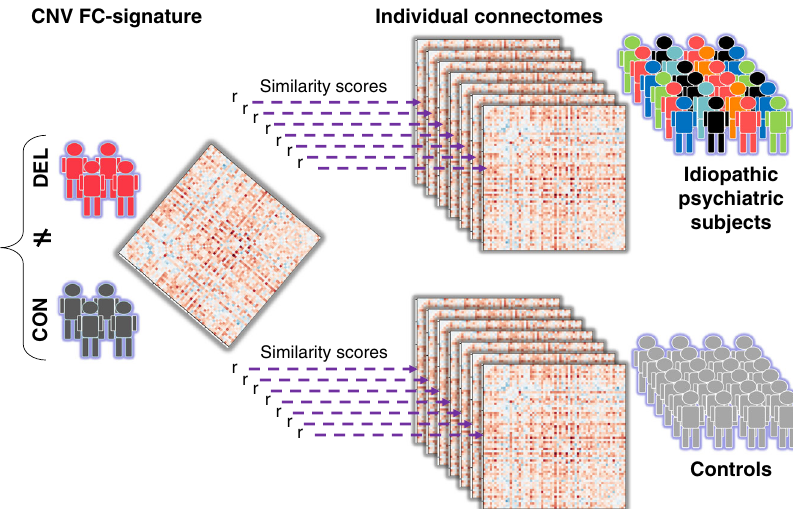
Fig. 3 Testing similarities across CNVs and idiopathic conditions. Similarities of FC-signatures across this study were characterized by correlating (Pearson ’ s r ) a group-level FC-signature with individual connectomes from either cases and controls. The r values obtained for all cases and all controls were compared using a Mann – Whitney test. Here, the group level connectome is represented by a matrix of 2080 beta values, on the left side. It is obtained by contrasting deletion cases (red) and controls (dark gray). The beta map is correlated to seven individual connectomes of psychiatric cases and seven connectomes of controls. The different colors used for psychiatric cases represent phenotypic heterogeneity.